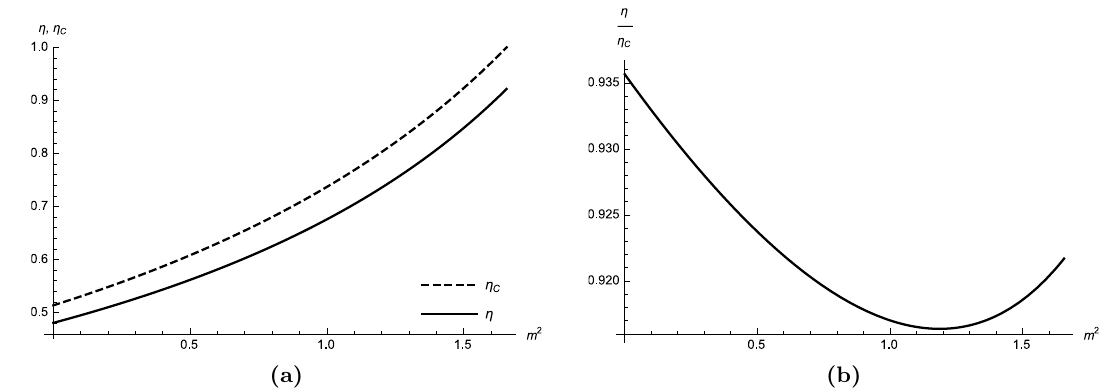
Figure 4 . A speci(cid:12)c example of (cid:12)ve-dimensional neutral black holes with the parameters chosen as k = 1 ; c 0 = 1 ; c 1 = (cid:0) 2 ; c 2 = (cid:0) 3 ; c 3 = (cid:0) 4 ; P 1 = 2 ; P 4 = 1 ; S 1 = 8 ; S 2 = 10 (a) (cid:17); (cid:17) C as the function of m 2 (b) (cid:17)=(cid:17) C as the function of m 2